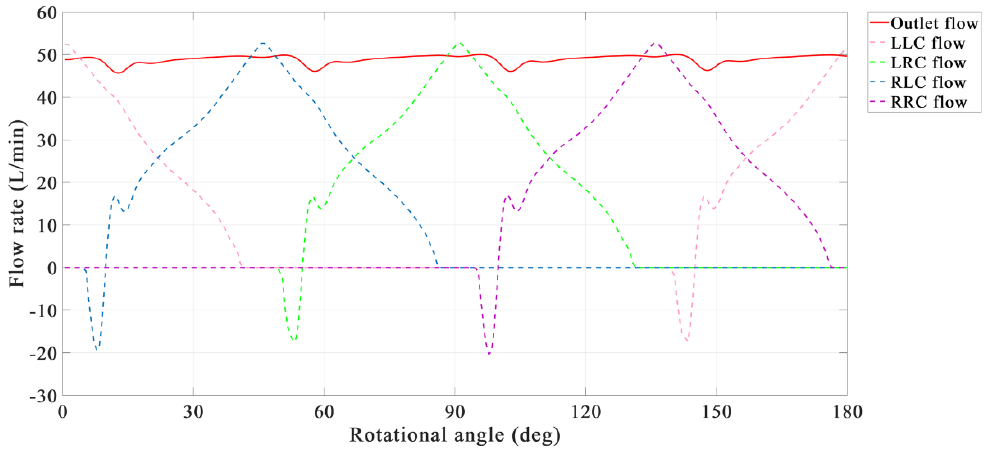
Figure 17. The outlet flow of the parallel 2D piston pump.